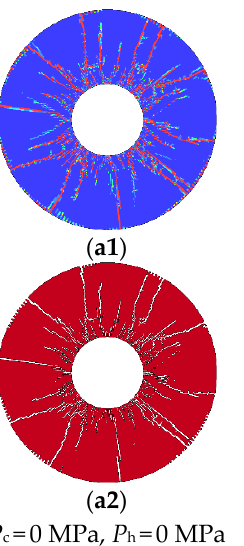
Figure 13. Case 2: ( a1 , b1 , c1 , d1 ) damage distribution in rock; ( a2 , b2 , c2 , d2 ) crack pattern.